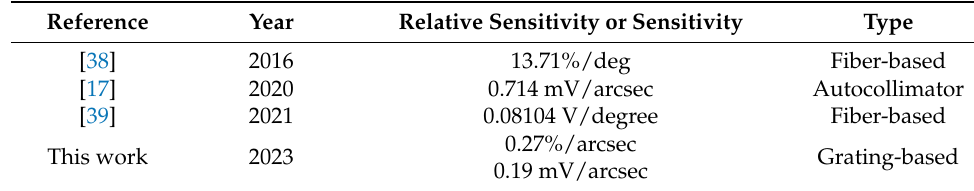
Table 1. Comparison of miniaturized optical sensors.